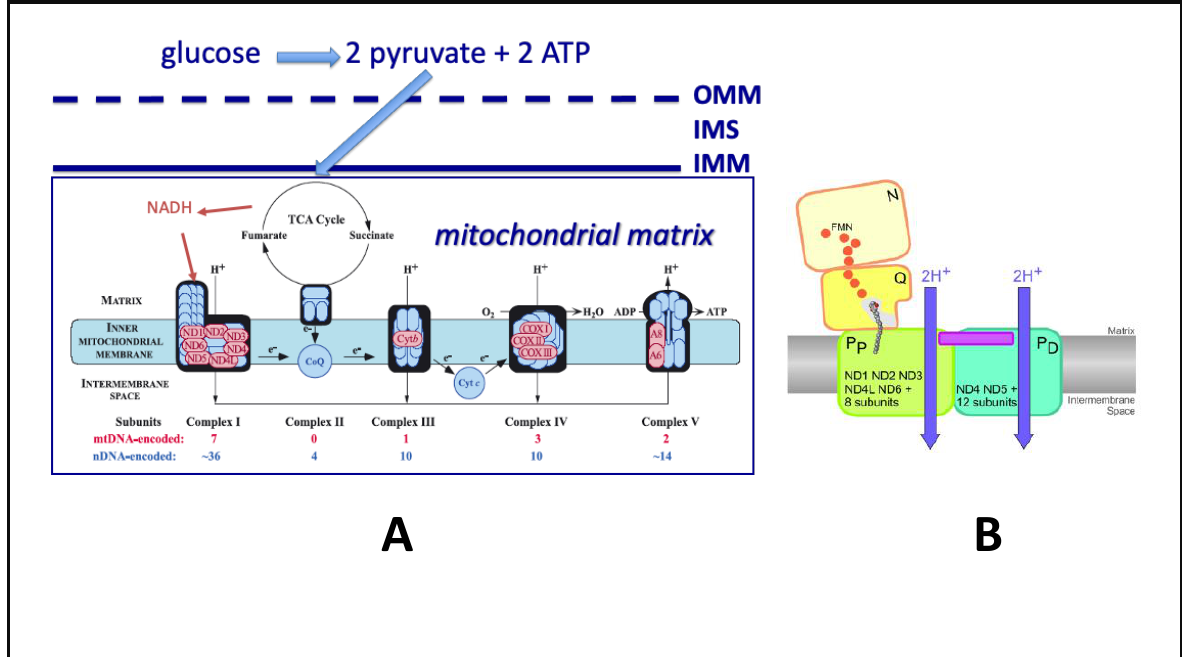
Figure 2. Overview of Mitochondrial Electron Transport Chain ETC/Oxidative Phosphorylation (OXPHOS) and ATP Production. (A). (left) Linear representation of the mitochondrial ETC/OXPHOS system. Shown are the 5 mitochondrial complexes involved in ETC/OXPHOS. In pink are the 13 individual protein subunits derived by transcription of mtDNA genes (usually maternally derived) and translated in the mitochondrial matrix. In blue are the protein subunits derived from nDNA (paternally and maternally derived) that are synthesized in the cytosol and imported into mitochondria. Mammals are now thought to have a total of 45 subunits in Complex I (7 from mtDNA, 38 from nDNA). In the brain, glucose is believed to be the major carbon energy source that is transformed to ATP. In other tissues, mitochondria can metabolize fatty acids and amino acids. Glucose (6 carbons) is broken down outside of mitochondria into 2 pyruvate molecules (3 carbons each) by glycolysis, and the resulting pyruvate is imported into the mitochondrial matrix by specific pyruvate carrier proteins that span the relatively protein-rich outer mitochondrial membrane (OMM), the intermembrane space (IMS), and the relatively lipid-rich inner mitochondrial membrane (IMM). Once in the matrix, pyruvate is oxidatively decarboxylated by the tricarboxylic acid cycle (TCA cycle), yielding reducing electrons that in pairs reduce the electron carrier NAD + to NADH. NADH is subsequently oxidized back to NAD + at Complex I (thus its name, NADH-NAD oxidoreductase ) and transfers its two electrons to flavin mononucleotide (FMN) that is embedded in the hydrophilic (matrix) arm of